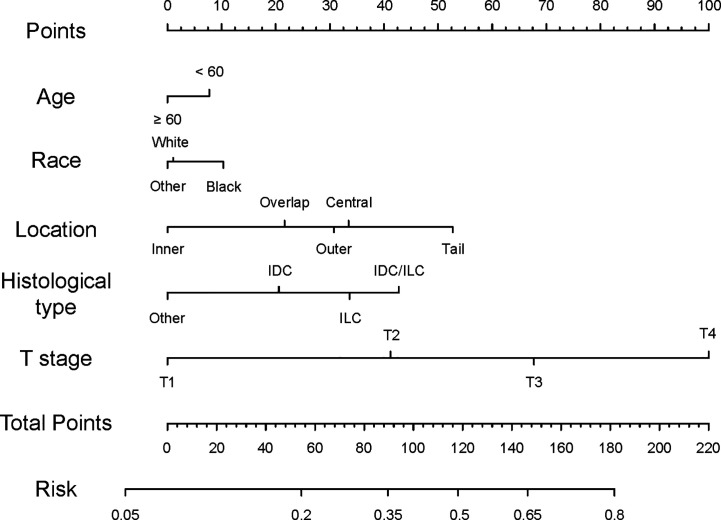
Nomogram predicting lymph node status of TNBC patients. Instructions for the nomogram: First, quantify each characteristic of the patient by drawing a vertical line from corresponding scale to the points scale. Then, sum all the points and draw a vertical line from the total points scale to the risk scale to obtain the probability of lymph node metastasis.